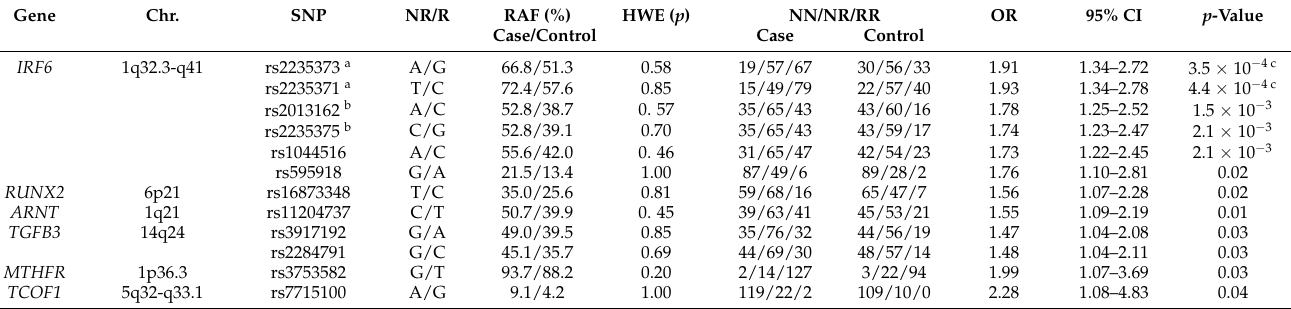
Table 1. SNPs associated with NSCL/P in Fisher’s exact test ( p <